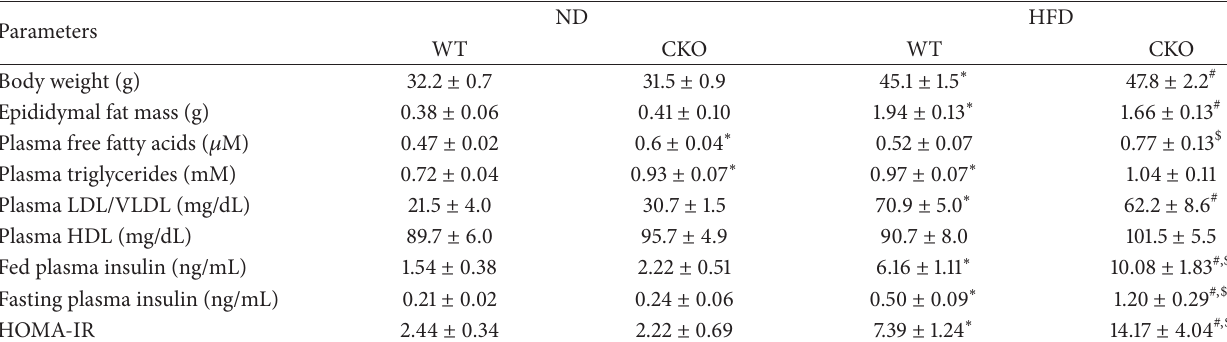
Table 2: Metabolic characteristics of experimental